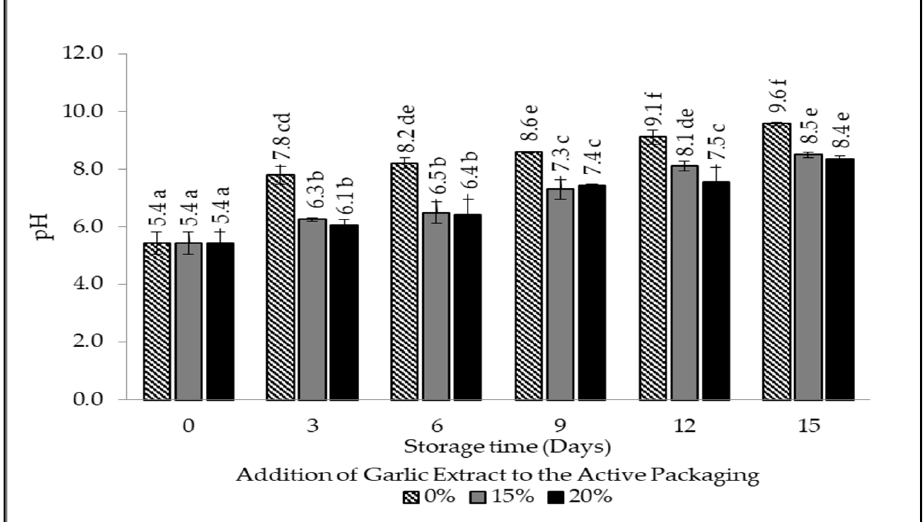
Figure 7. The pH value of beef packaged using intelligent and active packaging with the addition of garlic extract. The mean value followed by various letters indicates a significant difference ( p < 0.05).